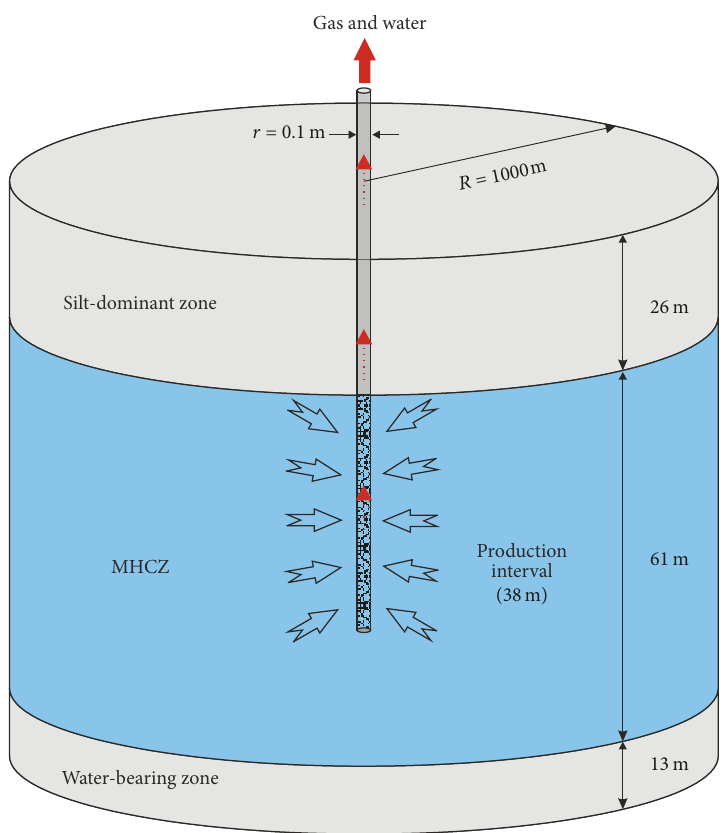
Figure 4: The geometry of the simulation domain and the configuration of production well.